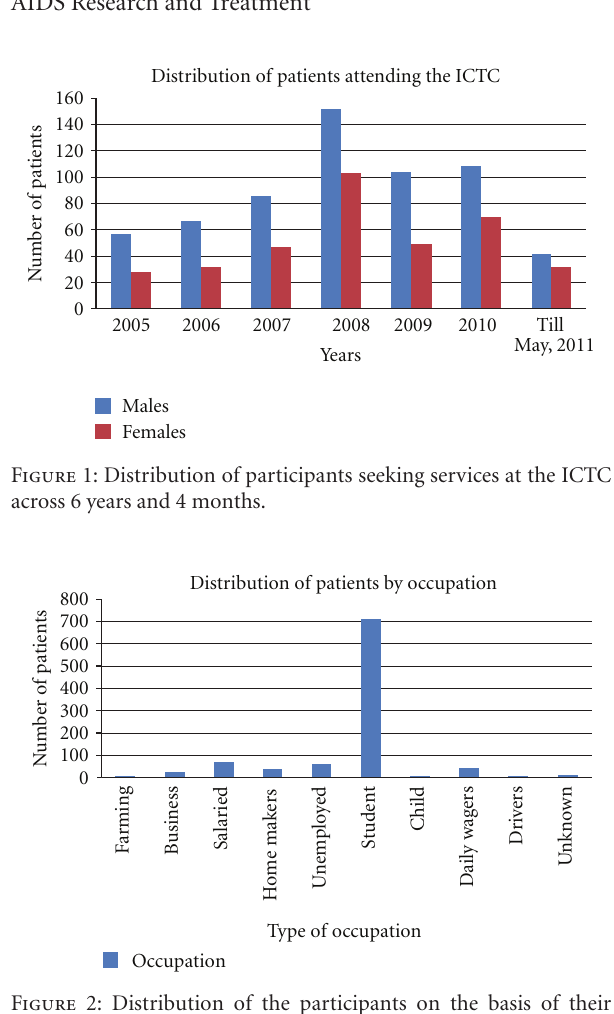
Figure 2: Distribution of the participants on the basis of their Occupation.